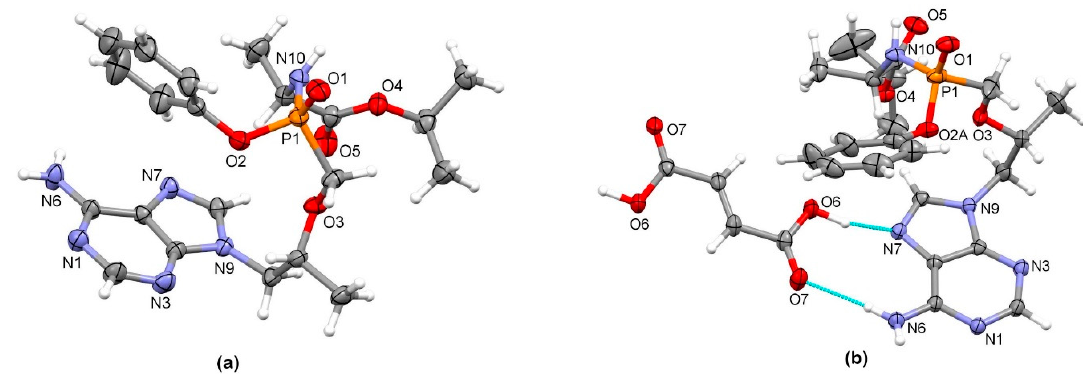
Figure 3. Thermal ellipsoid figures of ( a ) TA and ( b ) TA HF drawn at the 30% probability level. The asymmetric unit of TA HF contains one tenofovir alafenamide molecule and half of a molecule of fumaric acid. The disorder of the phenyl and isopropyl groups in TA HF is omitted for clarity. Hydrogen bonds are drawn with dashed blue lines.